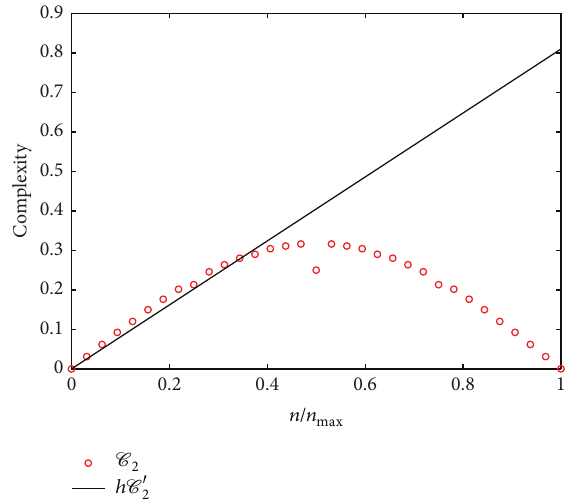
Figure 2: Comparison of the second terms of the complexities in their continuous and discrete versions, ℎ C 󸀠 2 and C 2 , for the two- dimensional set of trigonometric functions from (15) as a function of 𝑛/𝑛 max